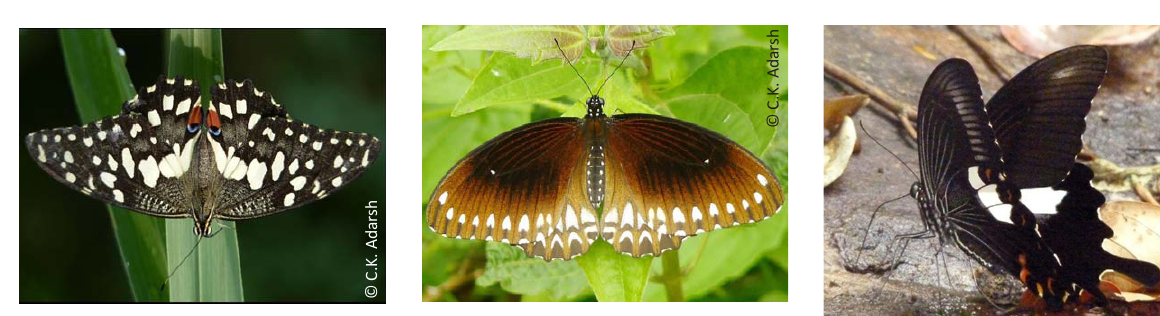
HelenImage 7. Papilio demoleus Lime Butterfly